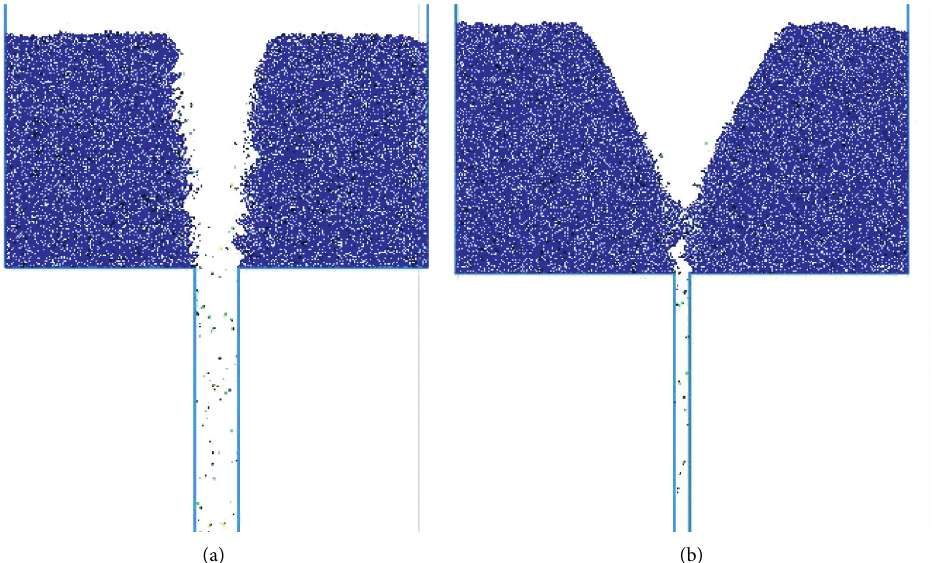
Figure 13: Sand inrush funnel. (a) Specimen 6–90 and (b) Specimen 2–90.